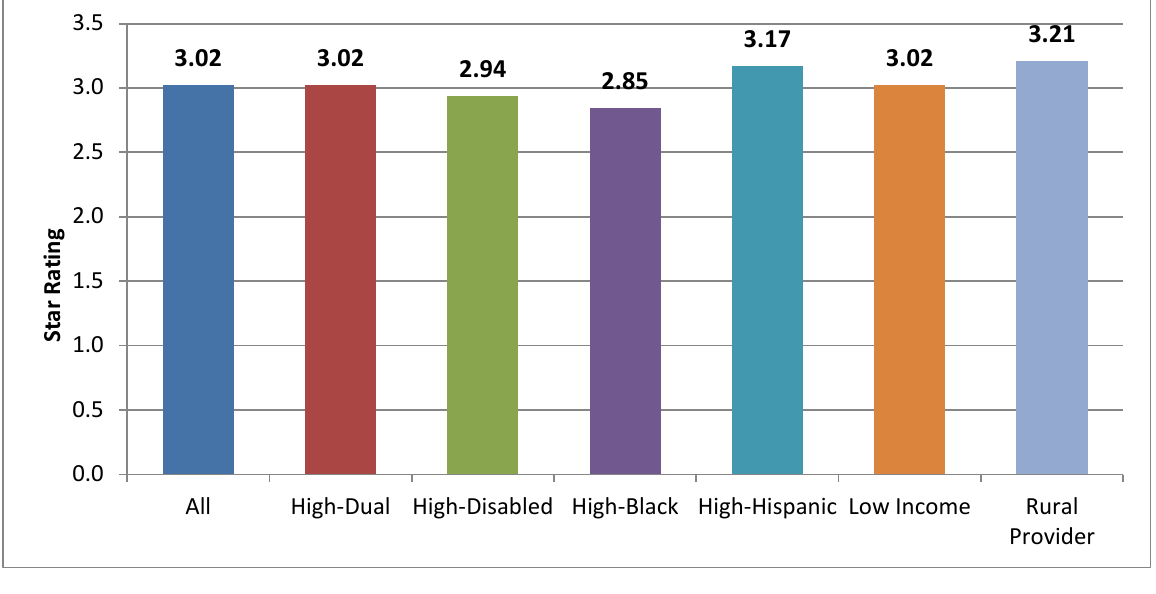
Figure 11.6: Star Ratings by Facility